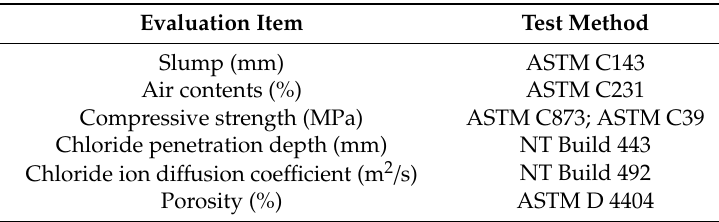
Table 5. Test methods for each evaluation